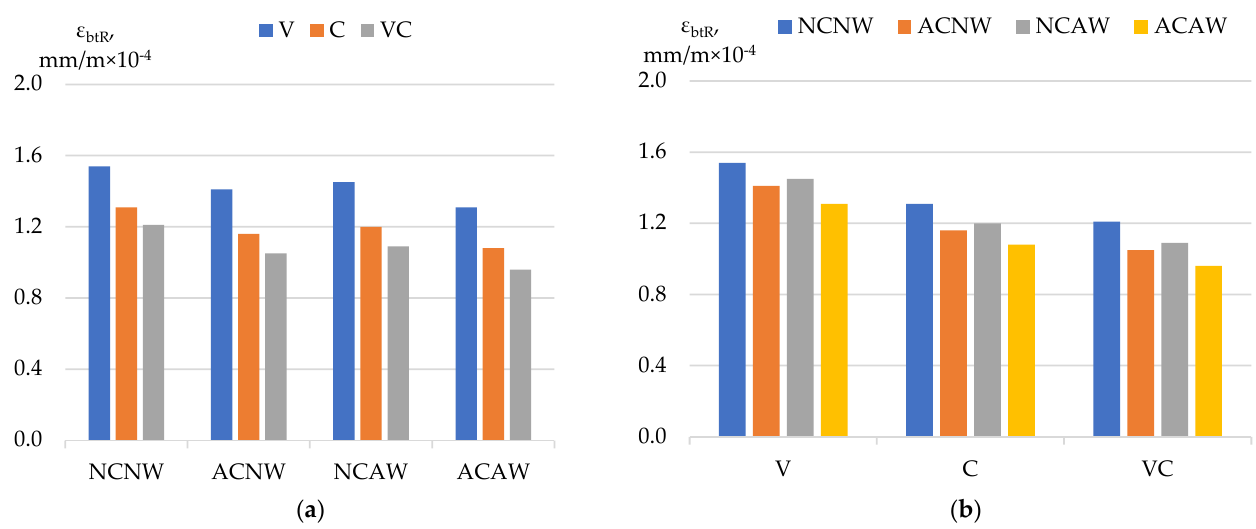
Figure 10. Dependence of deformations during axial tension of concrete: ( a ) on the type of activation, ( b ) on the type of technology for its manufacture.